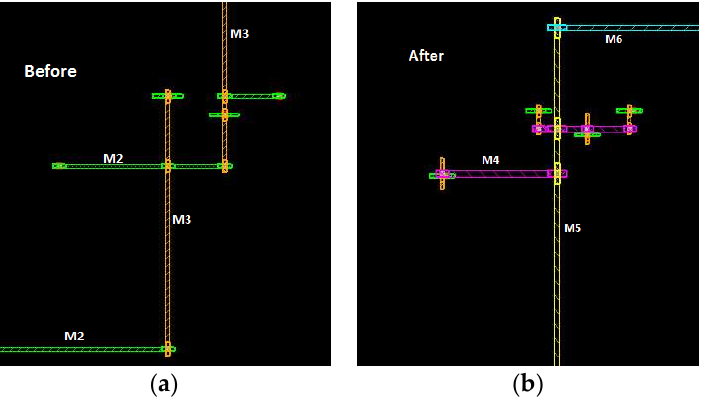
Figure 13. Net#3: detail wire used layers before ( a ) and after ( b ) optimization.